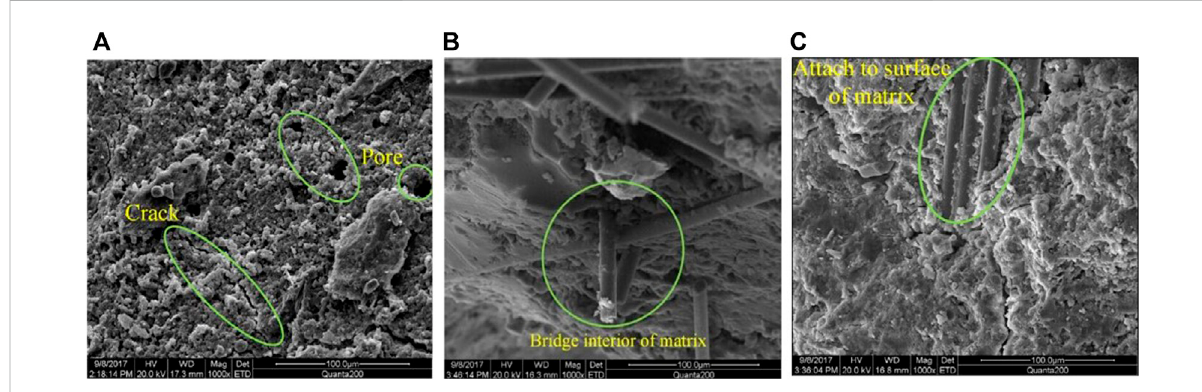
FIGURE 7 Microstructure of BFRC with BF content of 0%, 0.2% and 0.5% (Sun et al., 2019a) (A) BF content of 0% (B) BF content of 0.2% (C) BF content of